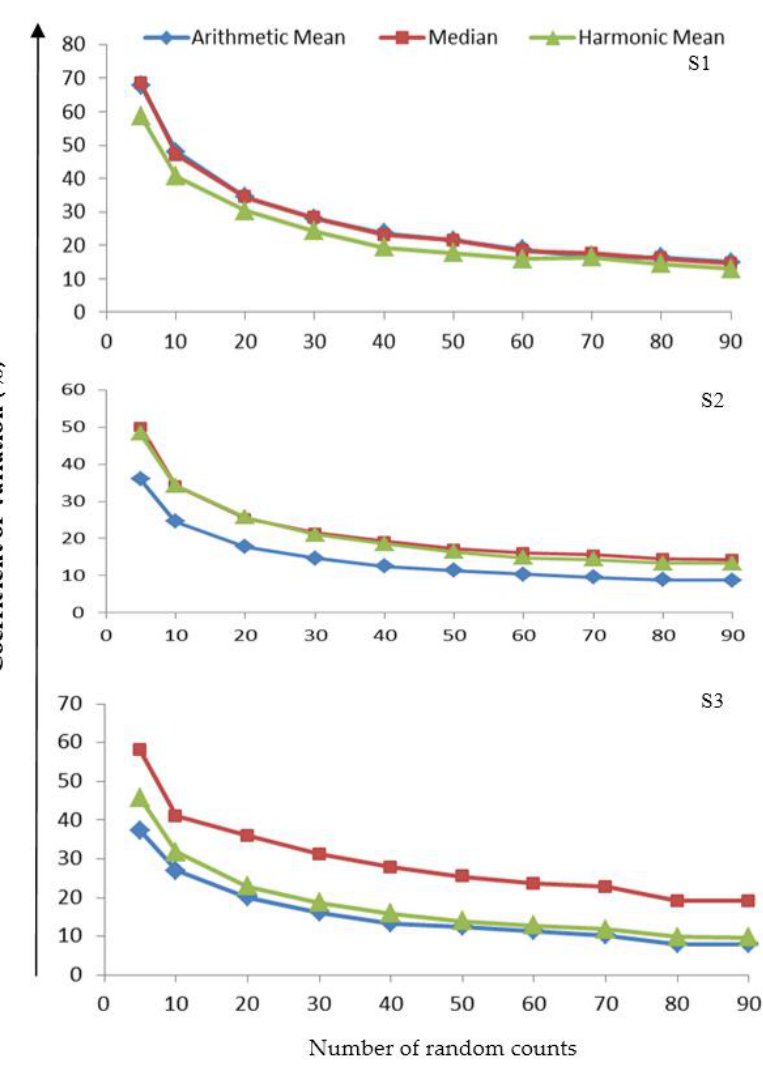
Figure 7. Coefficient of variation plots for each of the samples S1, S2 and S3 showing the CV percentage for each of the estimated statistical measures (arithmetic mean, median and harmonic mean) based on the random counts generated by bootstrapping ( n = 5, 10, 20, 30, 40, 50, 60, 70, 80 and 90 each 1000 iterations with replacement).